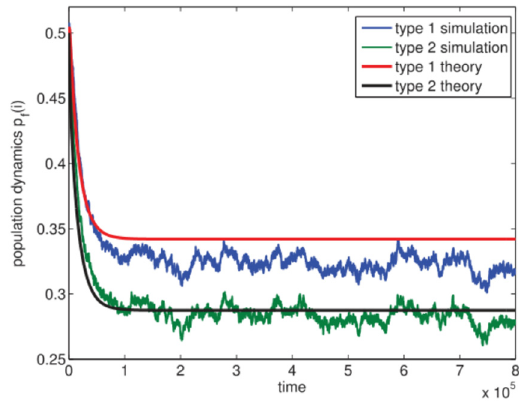
Figure 6. Simulation results of the evolutionary dynamics for the unknown user type